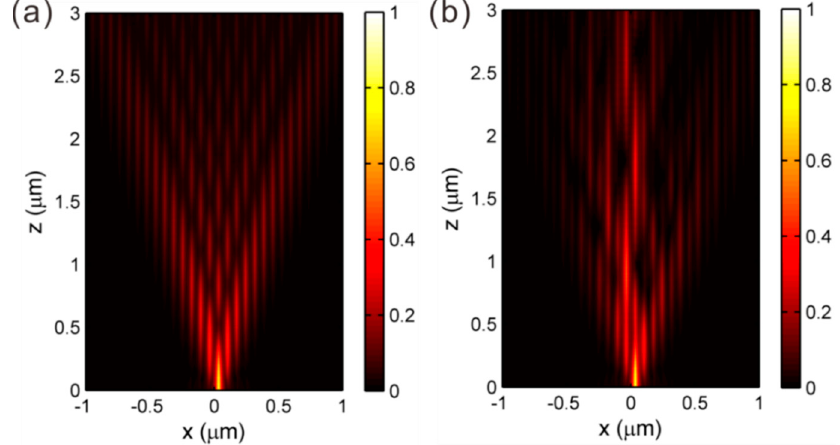
Figure 4. The propagation of surface plasmon polaritons (SPPs) for a single-waveguide excitation. ( a ) µ 1 = µ 2 = 0.15 eV. ( b ) µ 1 = 0.15 eV and µ 2 = 0.18 eV.